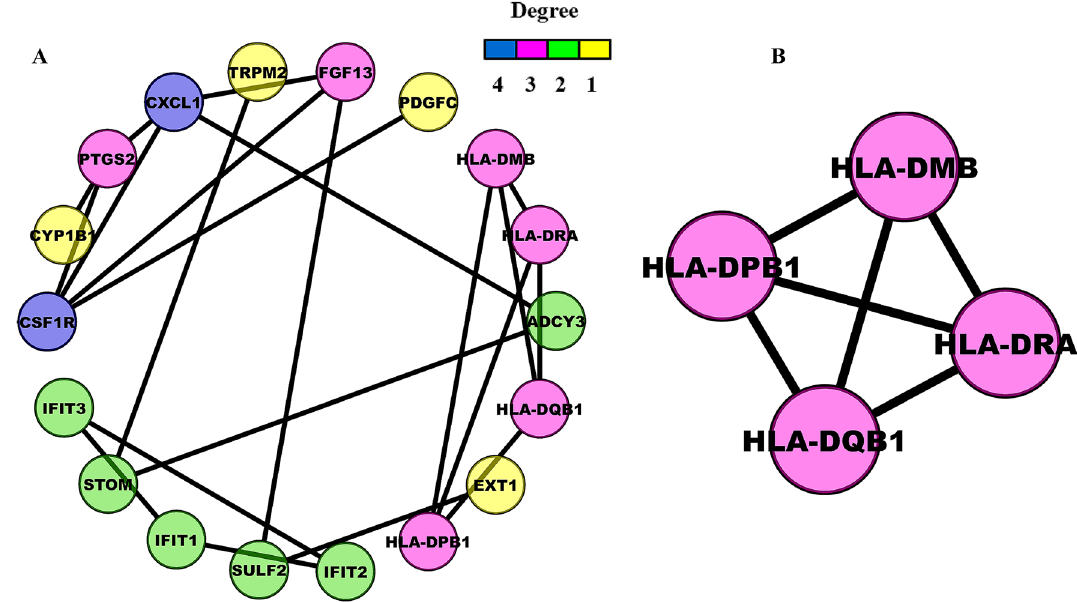
Figure 4. (A) Undirected PPI network containing 18 nodes and 21 edges corresponding to STRING interaction score > 0.4 . The node color varies with respect to degrees. (B) Highest-scoring PPI hub module with four nodes and six edges.